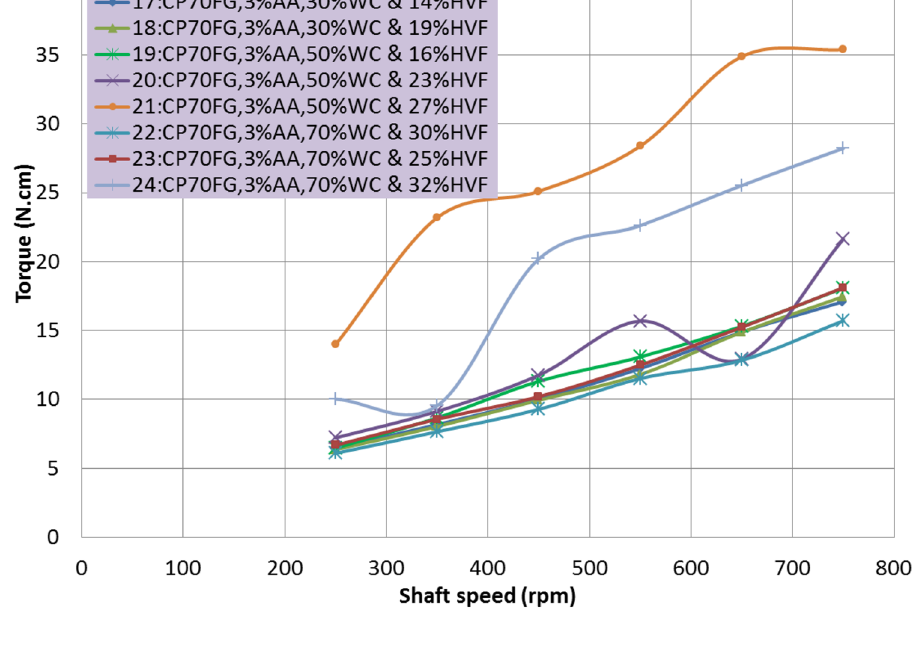
Fig. 18 In situ viscosity of hydrate slurries formed from PA-3-water systems. AA anti- agglomerant, WC watercut, HVF hydrate volume